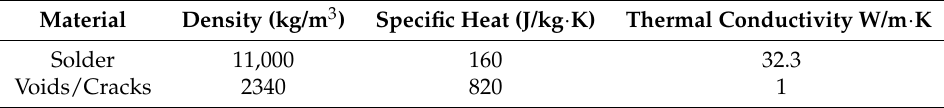
Table 1. Comparation of Properties between the Solder and Voids/Cracks.